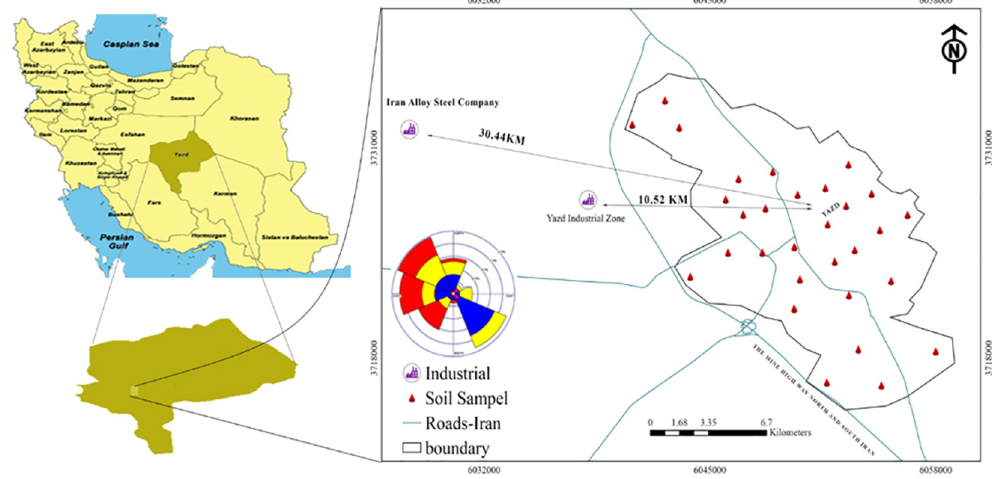
Fig 1. The position of Yazd province in Iran and the urban soil sampling points in Yazd city.